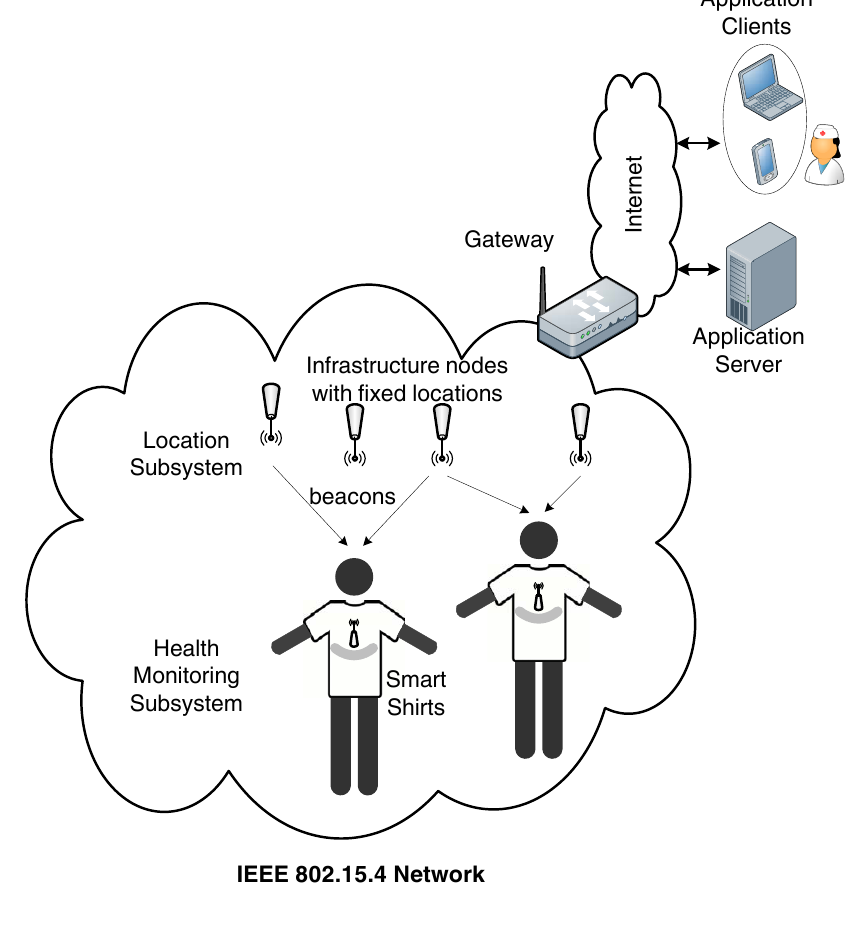
Figure 7. Example of the monitoring and location tracking mHealth system